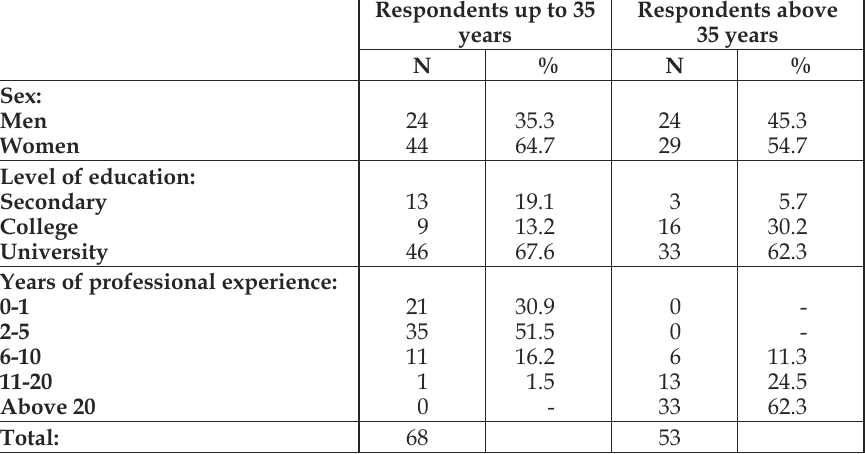
Tab. 1. Demographic data for the two age groups (generations), N=121. Respondents up to 35